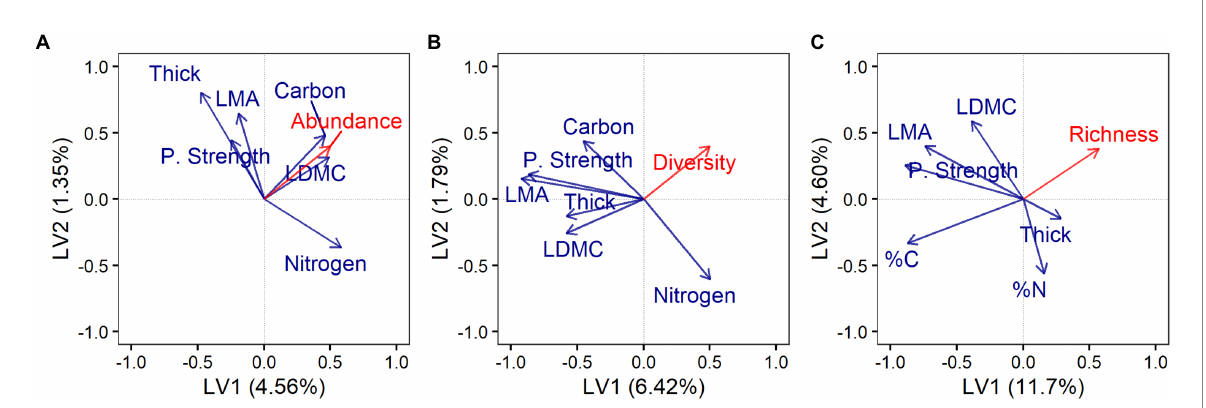
FIGURE 1 Endophyte abundance, diversity, and richness varied with leaf traits along the leaf economics spectrum. First two latent variables (LV) from partial least squares regression (PLSR) showing correlations between leaf functional traits (blue) and (A) endophyte abundance (culture-based survey; 24 host species), (B) endophyte diversity (culture-based survey; 24 host species), and (C) endophyte richness (culture-free survey; 11 host species). Axis labels indicate the variance in endophyte response explained by each LV. Model description and output can be found in the section “Materials and Methods,” Supplementary Tables S5, S6. Labels: Leaf mass per area (LMA); leaf dry-matter content (LDMC); leaf punch strength (P. Strength); leaf thickness (Thick); percent leaf carbon content (%C); and percent leaf nitrogen content